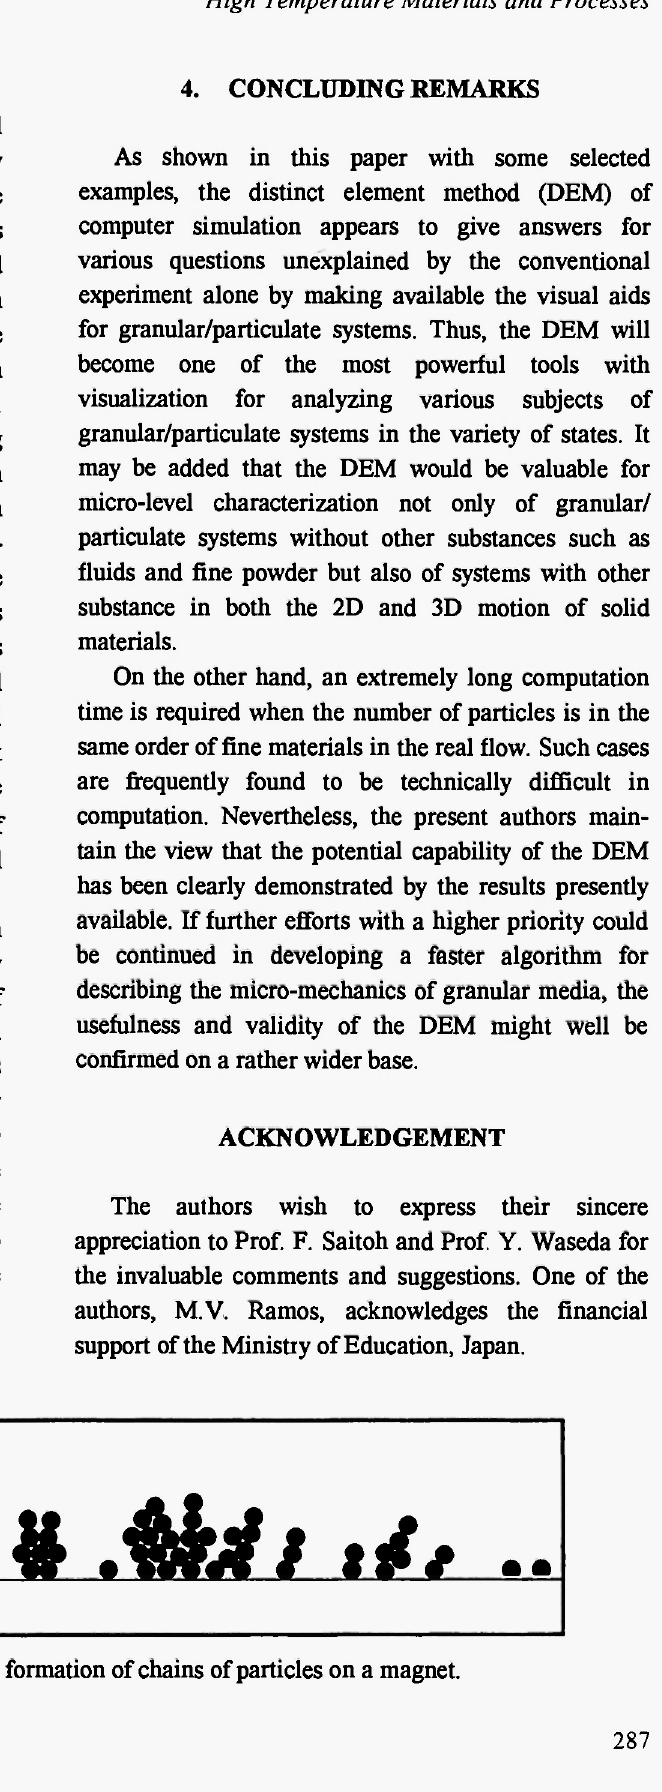
Fig. 13: Simulated profile showing formation of chains of particles on a